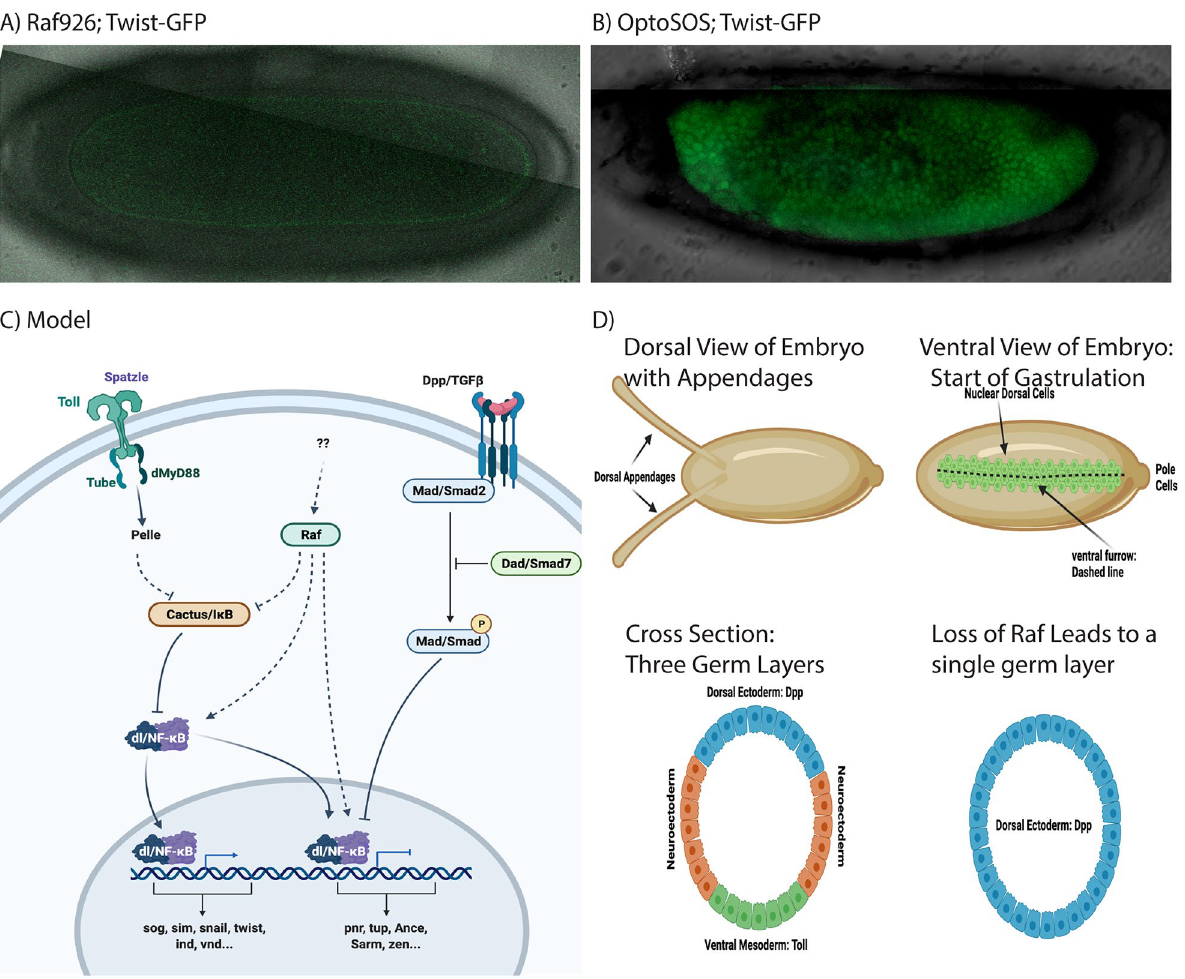
Figure 6. Opto-SOS drives Twist nuclear localization. ( A ) Live, confocal imaging of Twist-GFP expression in a Raf 926 embryo shows no expression. ( B ) Activation of Raf using Opto-SOS showed uniform Twist-GFP ( C ). A model for Raf in Dorsal/Ventral signaling. ( D ) Schematic representation of the Dorsal and Ventral sides of Drosophila embryos with dorsal appendages and ventral furrow cells highlighted followed by cross section views of the early germ layers as defined in wildtype and Raf mutants. Figures were drawn on